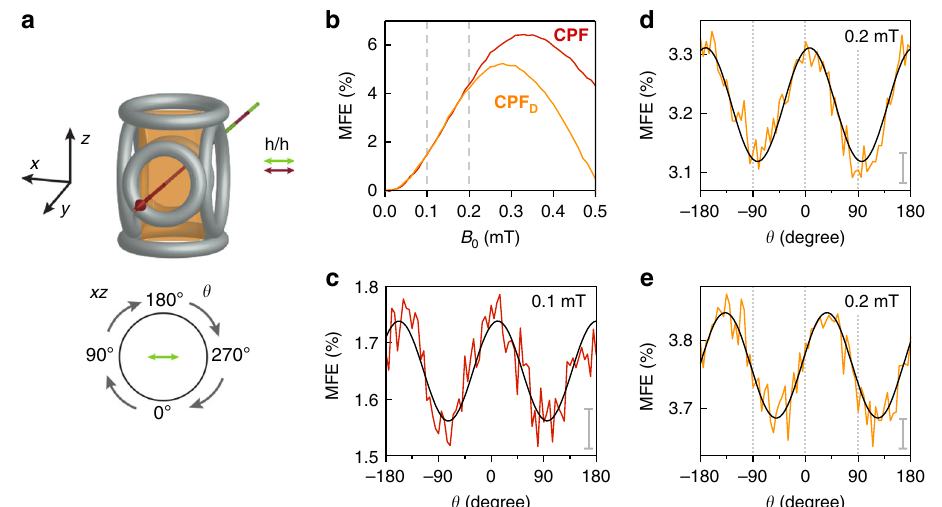
Fig. 2 Orientation dependence of the magnetic fi eld effect (MFE) of CPF . a Illustration of the experimental geometry. x , y and z indicate the three laboratory axes, θ de fi nes the angle between the − z axis and the applied magnetic fi eld. The polarisation axes of the pump and probe beams are parallel and are indicated in the fi gure. b MFE for CPF (red) and CPF D (orange) as a function of applied fi eld. The fi eld positions where the anisotropy curves were recorded are indicated by vertical dashed lines. c MFE of CPF , recorded at 100 μ T as a function of θ . d MFE data for CPF D , recorded at 200 μ T as a function of θ . e MFE recorded for CPF D and same parameters as d but recorded with the polarisation directions of both pump and probe beam rotated by 45° in the xz plane. The data shown in all panels were averaged over a time window from 0.07 to 0.09 μ s after laser excitation. The grey bars in panels c – e indicate the (average) standard deviation of the mean. The black solid lines represent best sinusoidal fi ts to the